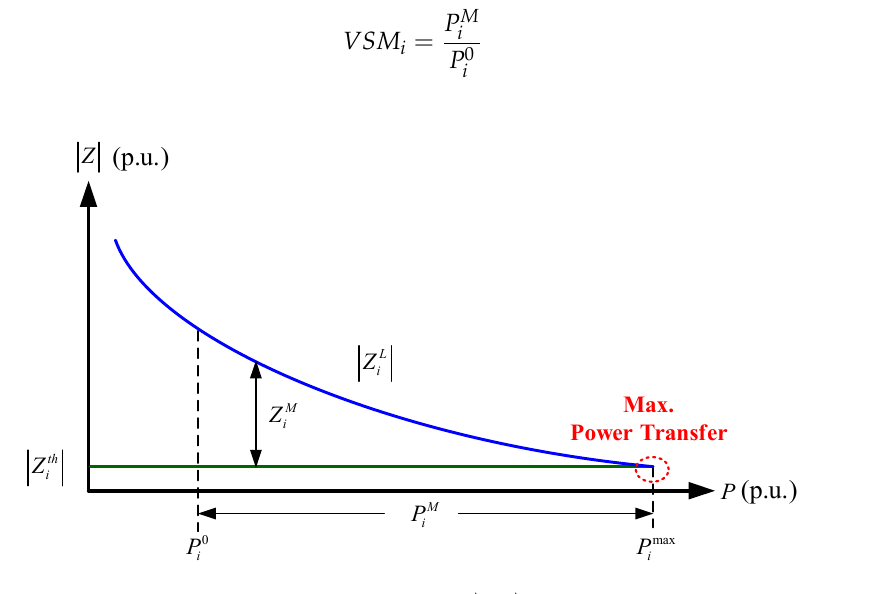
(cid:12) (cid:12) (cid:12) Z L i (cid:12) and